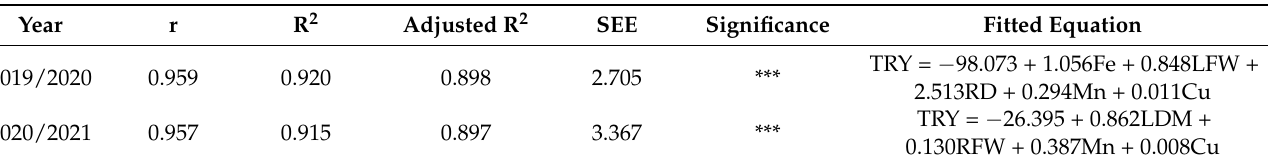
Table 9. Proportional contribution in predicting total root yield (TRY) using stepwise multiple linear regression for Zn deficiency-stressed carrot plants nourished by foliar spraying with different doses of zinc oxide nanoparticles in two